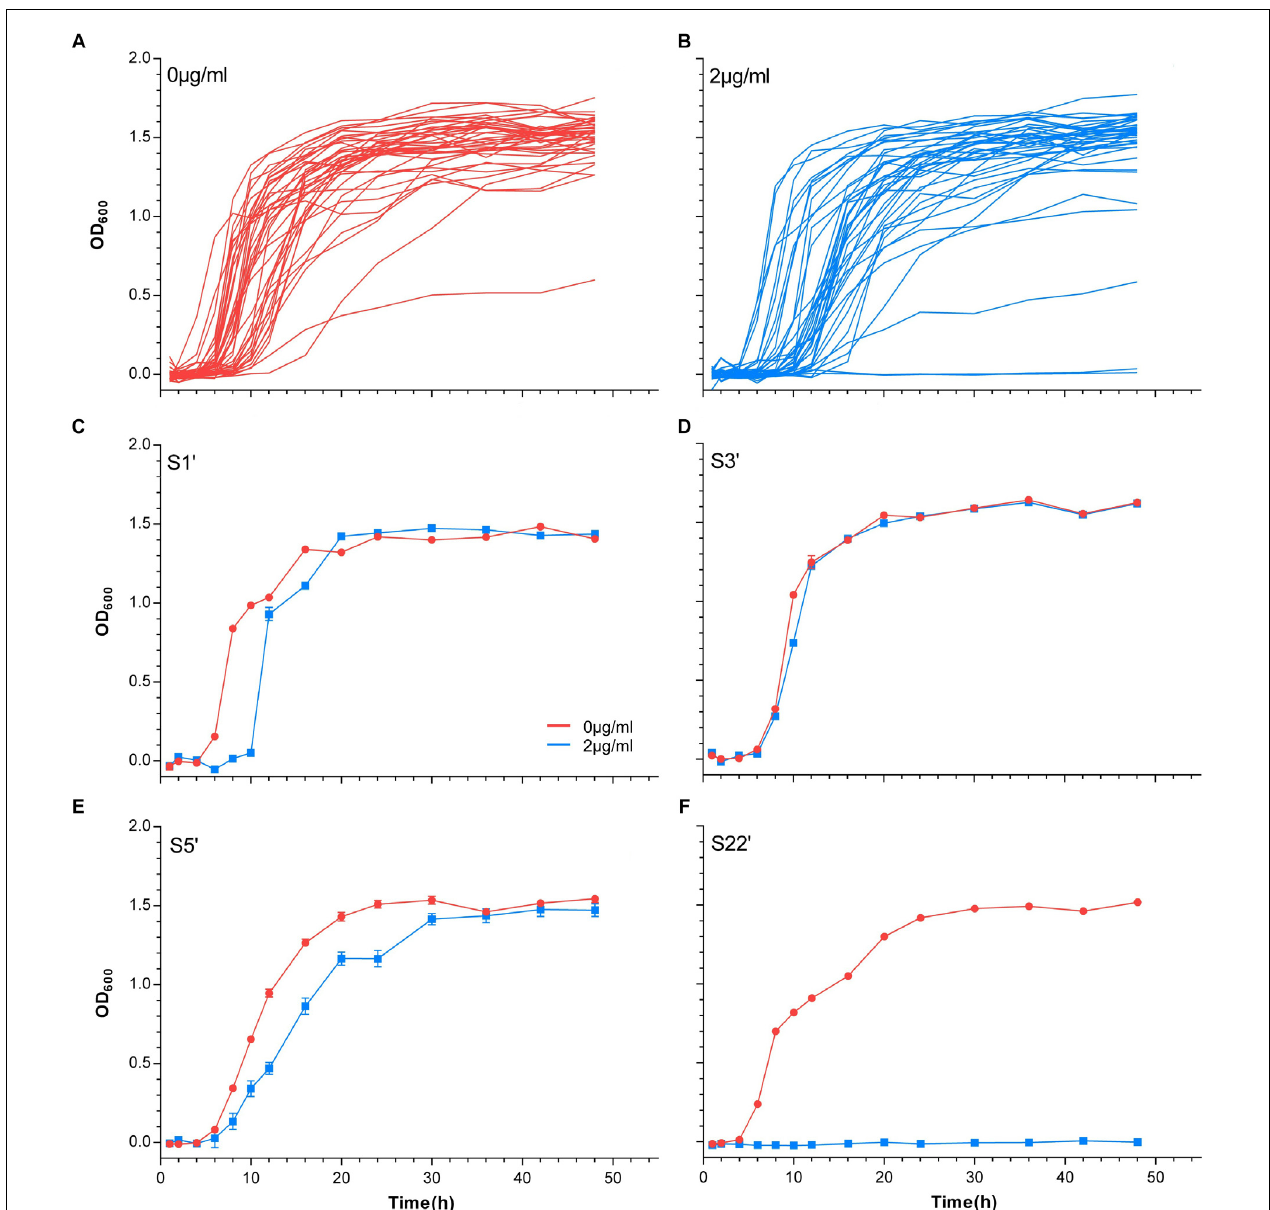
FIGURE 1 | Growth curves of S. aureus . The growth curves of all strains at 0 µ g/ml vancomycin culture (A) and 2 µ g/ml vancomycin culture (B) . (C–F) The growth curves of S1’, S3’, S5’, and S22’ at 0 and 2 µ